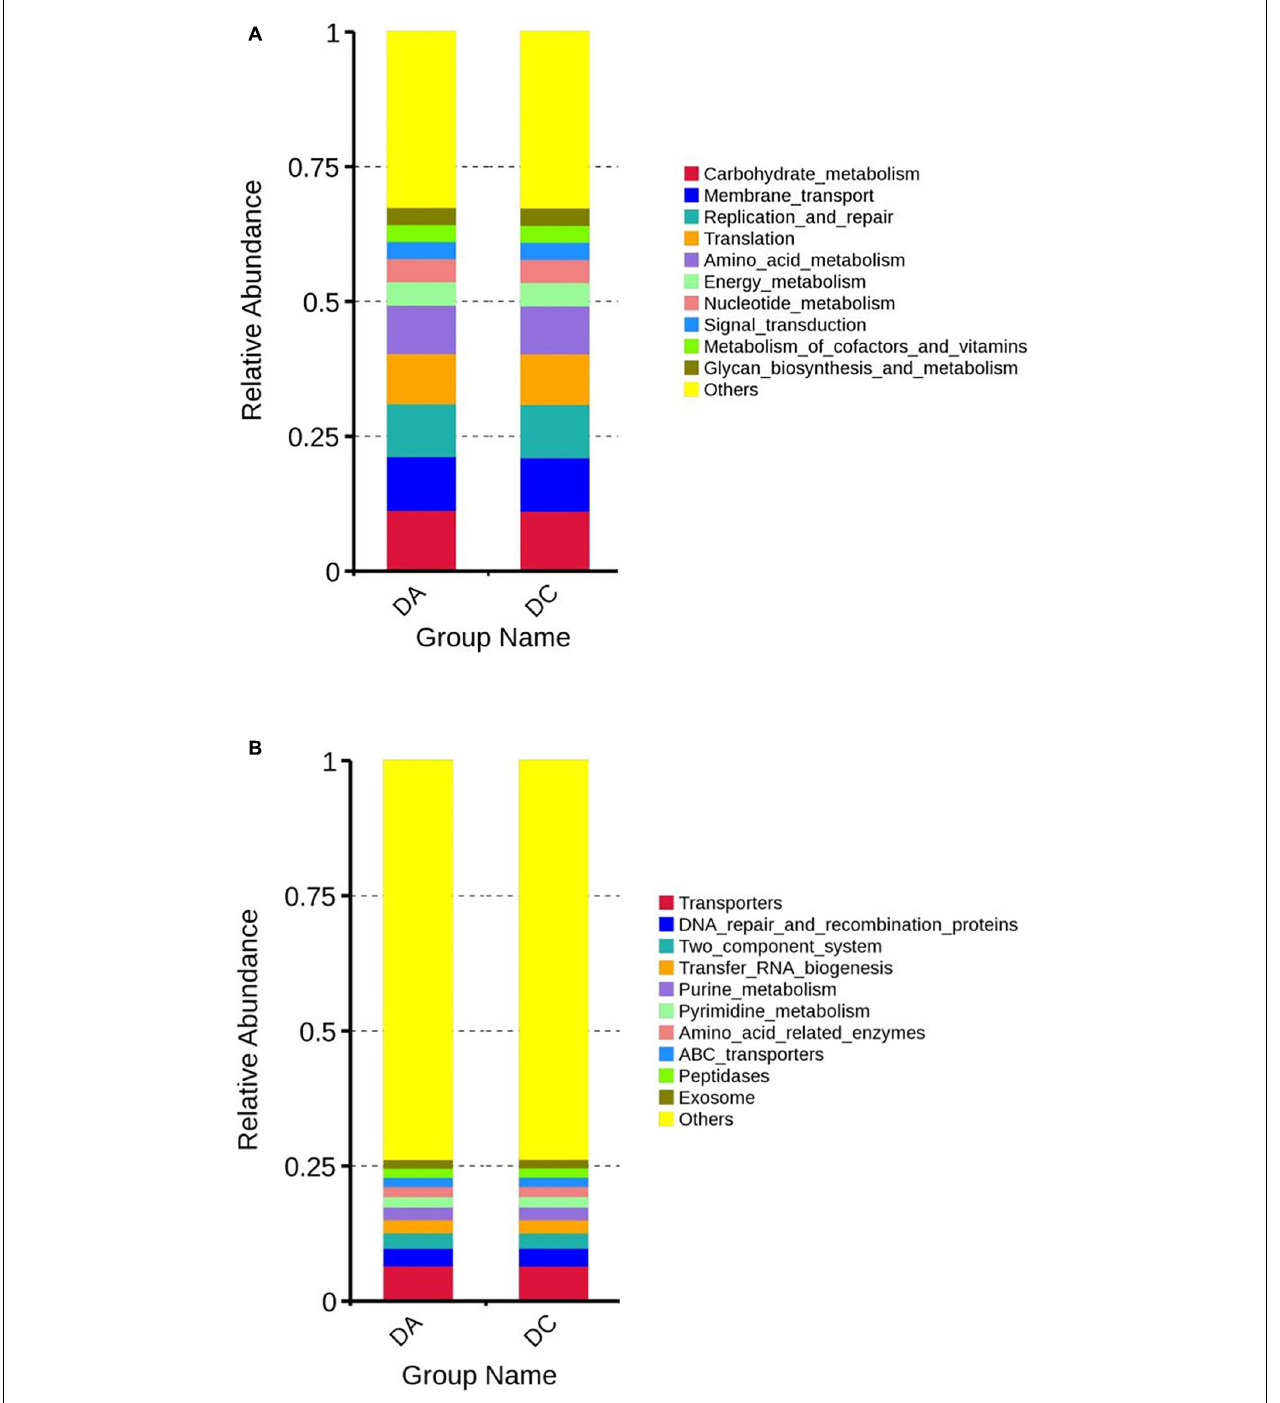
FIGURE 5 | The function annotation abundance map of the KEGG level 2 (A) and level 3 (B) .